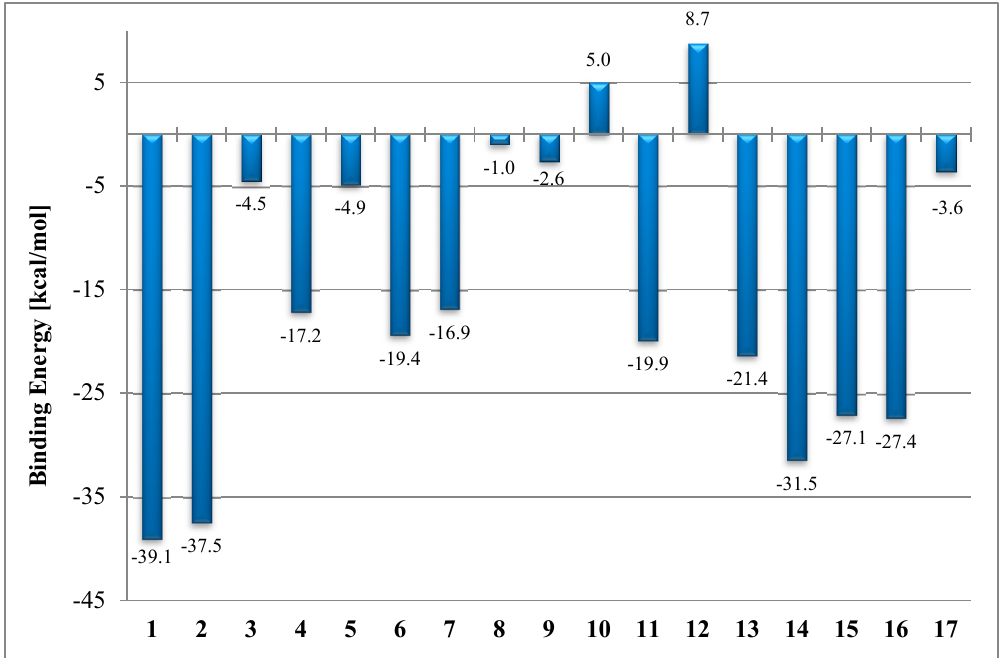
Figure 3. Comparison of binding energies of the tested compounds complexed with tubulin β I. Binding energies are estimated using the molecular mechanics generalized Born/surface area (MM/GBSA) method.